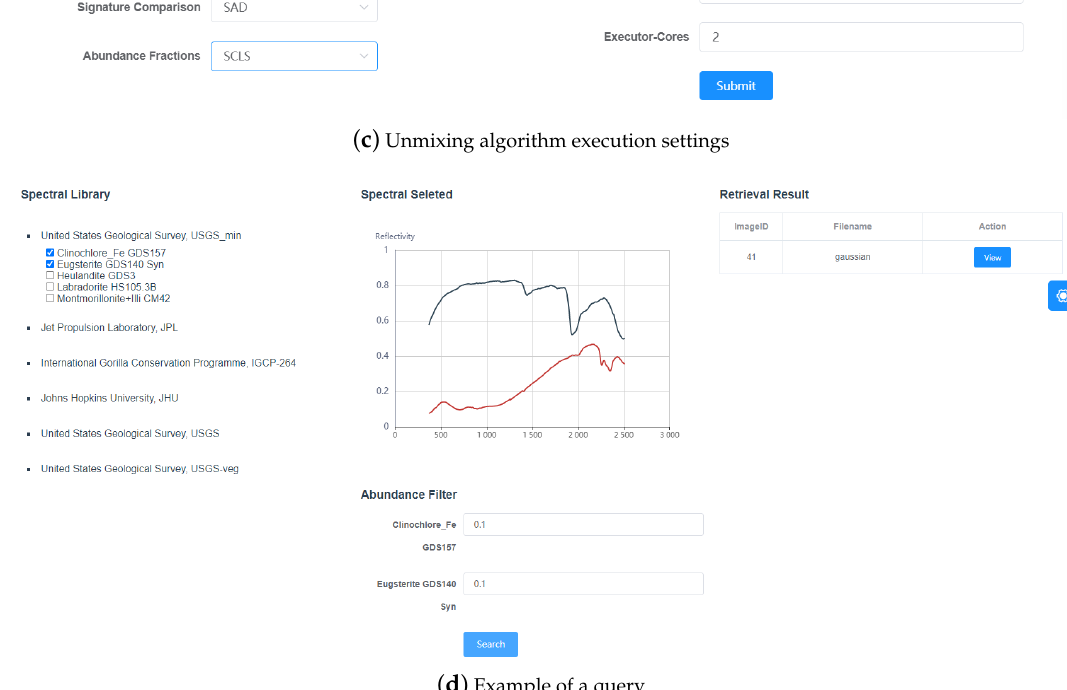
Figure 5. The CBIR system